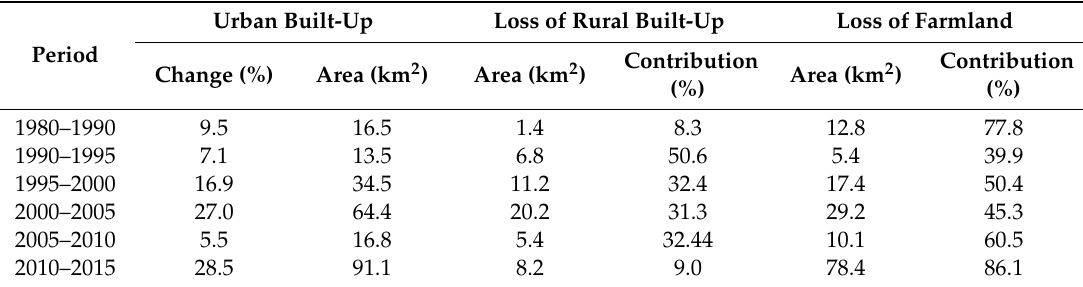
Table 3. Land-use change and percentage of contribution to urban built-up area for the di ff erent land-use categories between 1980 and